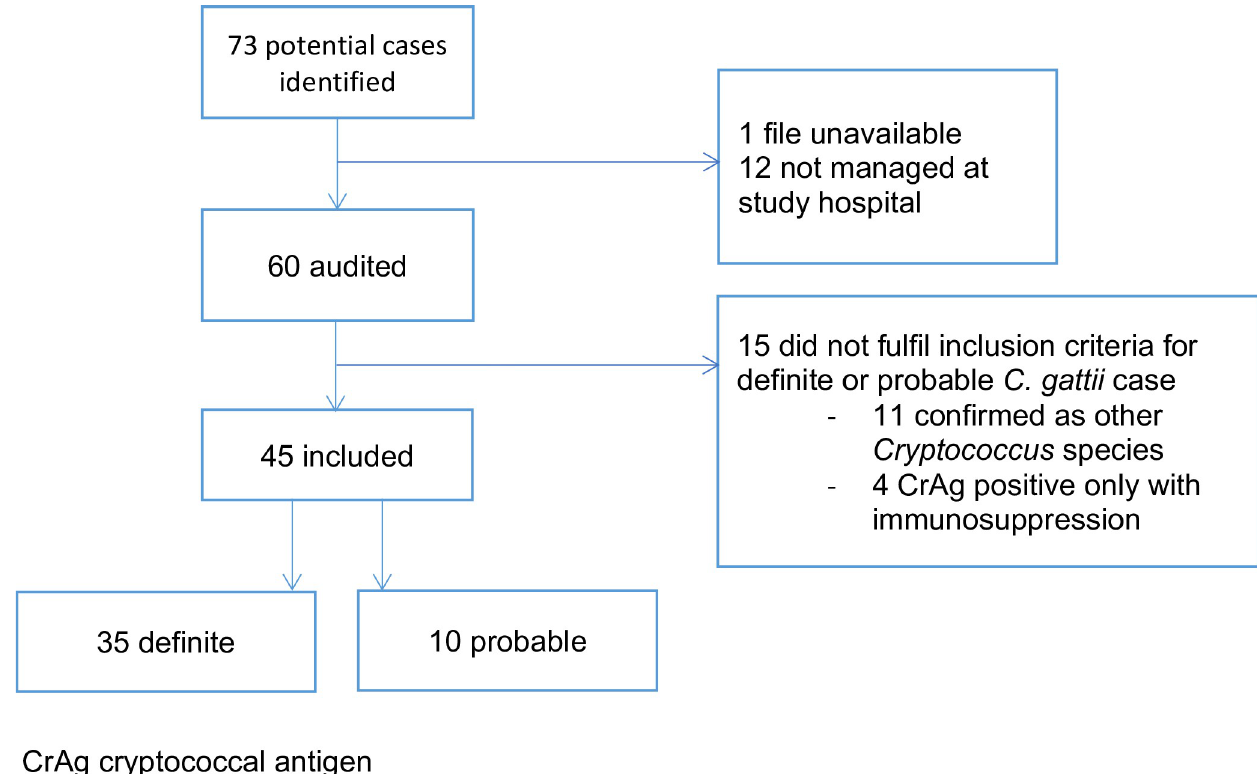
Fig 2. Study diagram. Note 12 patients not managed at study hospital–these are cases diagnosed at a hospital outside the Top End Region that refers some microbiological specimens to RDH for processing.